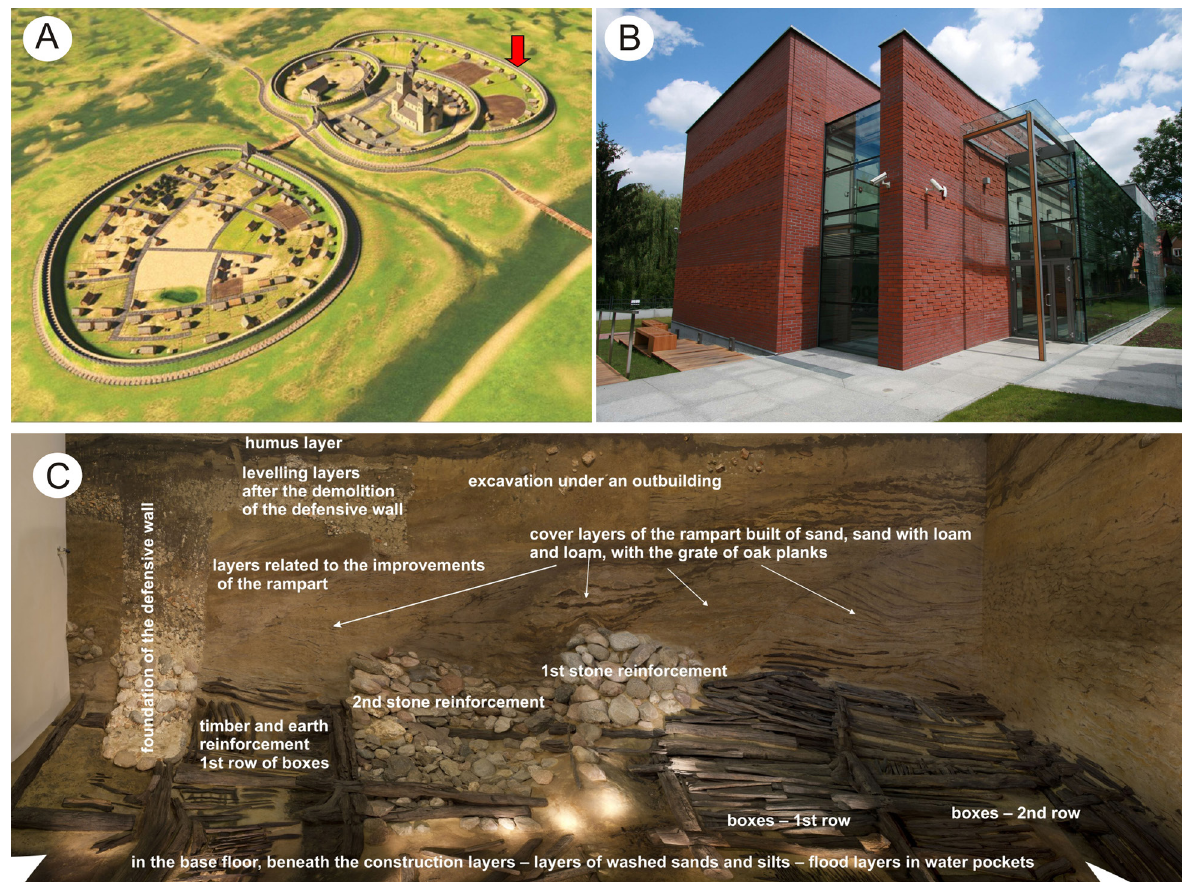
Fig. 11. Proposed urban geosite Genius Loci in ostrów Tumski,